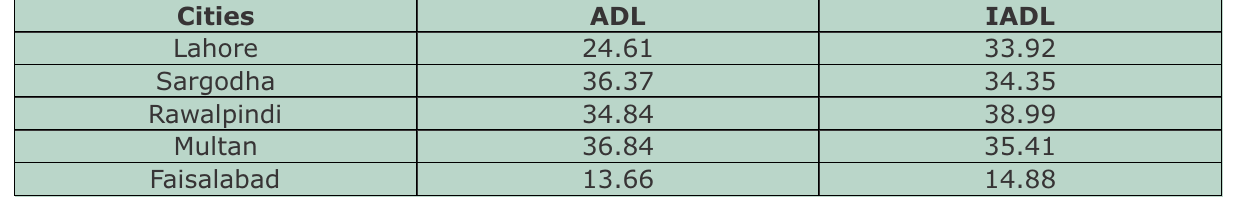
Table-II : Physical disability rates with reference to IADL and